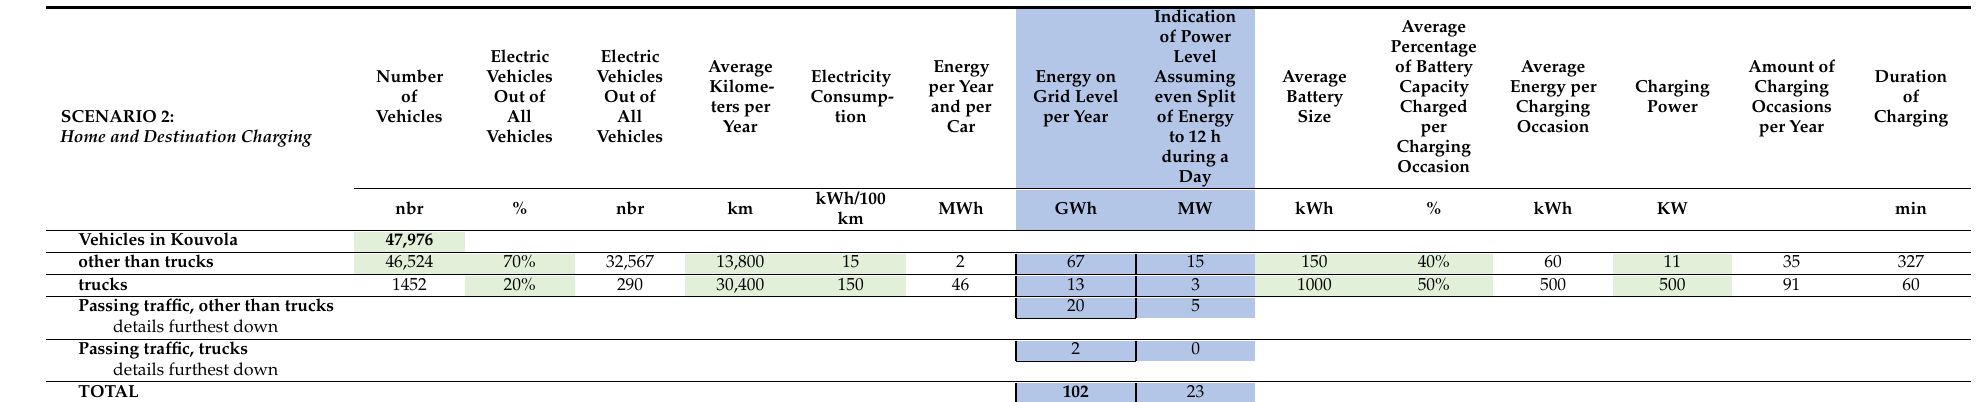
Table A4. Summary of Kouvola-based and passing traffic (including detailed quantification of the Kouvola-based traffic). Blue cells indicate results and green input parameters.